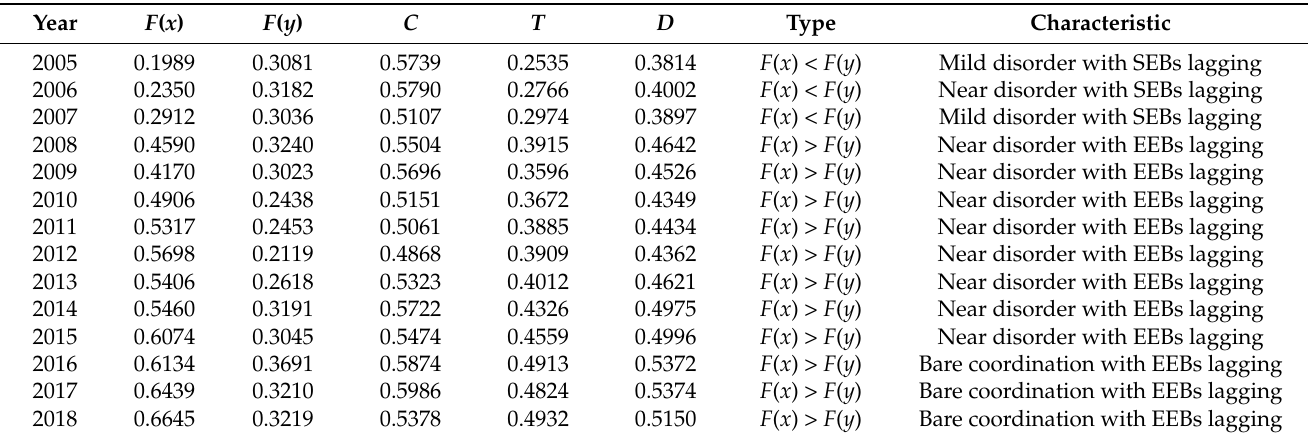
Table 5. CCD of the SEBs and EEBs systems for the Koktokay Global Geopark from 2005 to